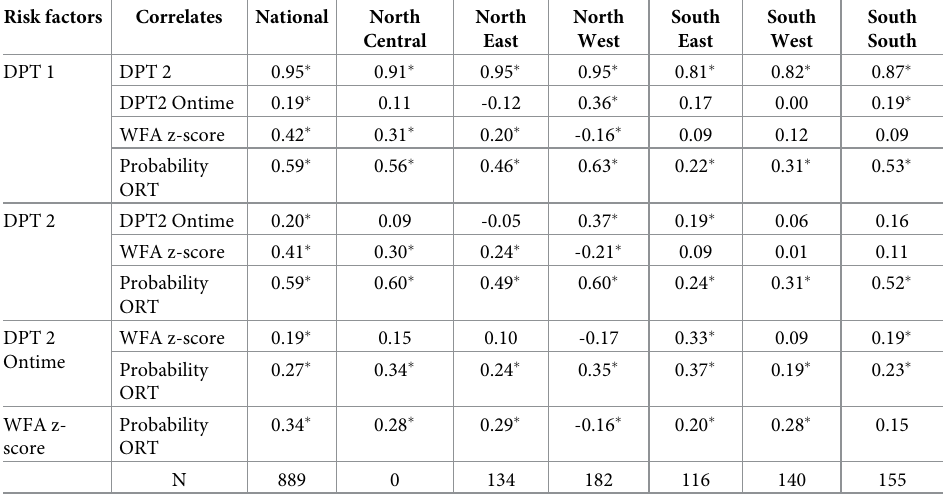
Table 5. Community level Pearson’s correlation coefficients of mortality risk factors and DPT